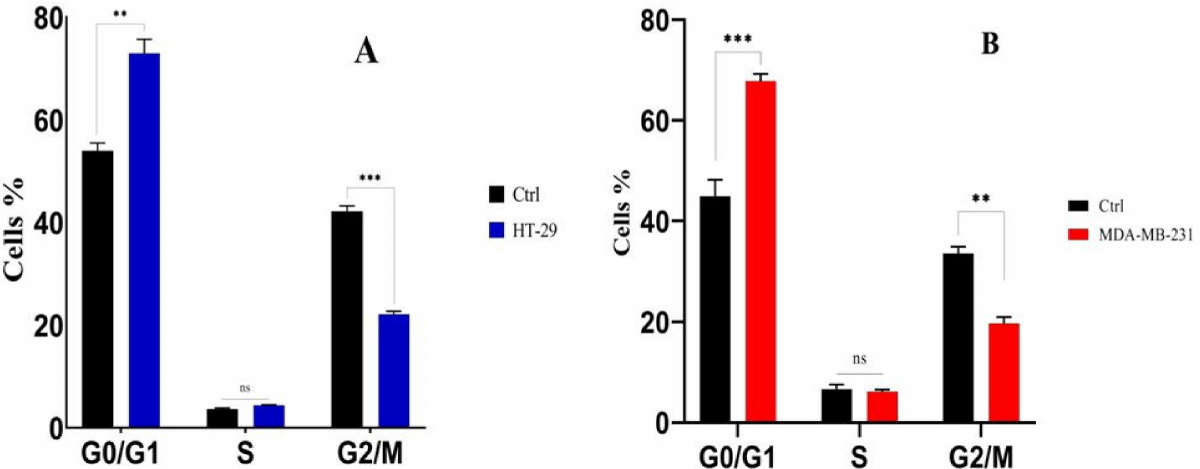
Figure 12. Evaluation of cell cycle phases in HT-29 and MDA-MB-231 cells after 24 h treatment. Leptulipin increased the number of cells in the G0/G1 phase and decreased the number of cells in the G2/M phase. ( A ) HT-29 and control. ( B ) MDA-MB-231 and control. N = 3, p < 0.01 (**), and p < 0.001